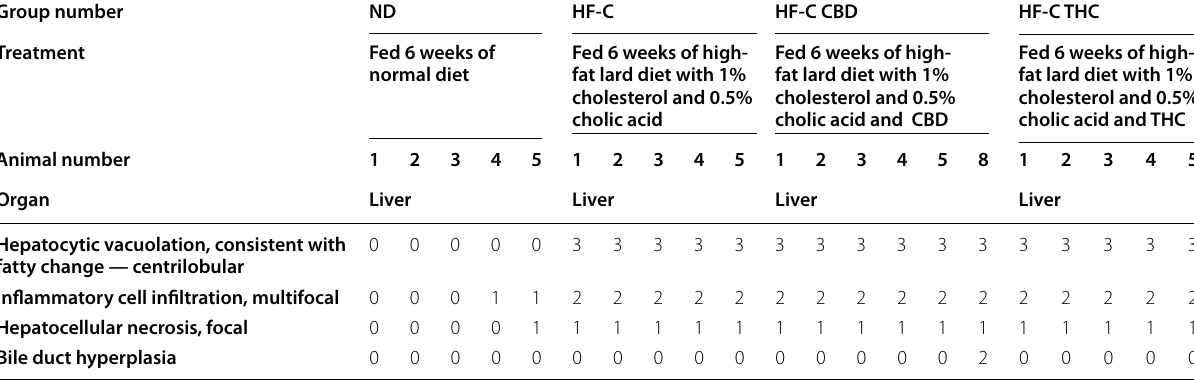
Table 3 Effect of THC or CBD treatment on liver steatosis in mice fed HFCD